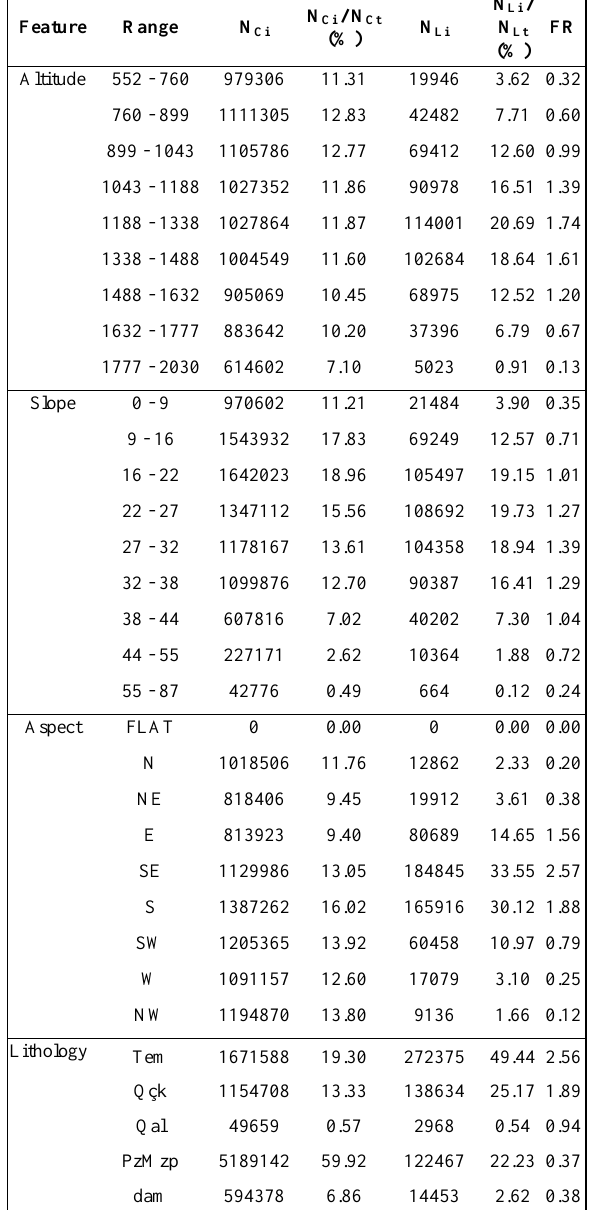
Table A3 . FR statistics Elazig part (altitude, slope, aspect,